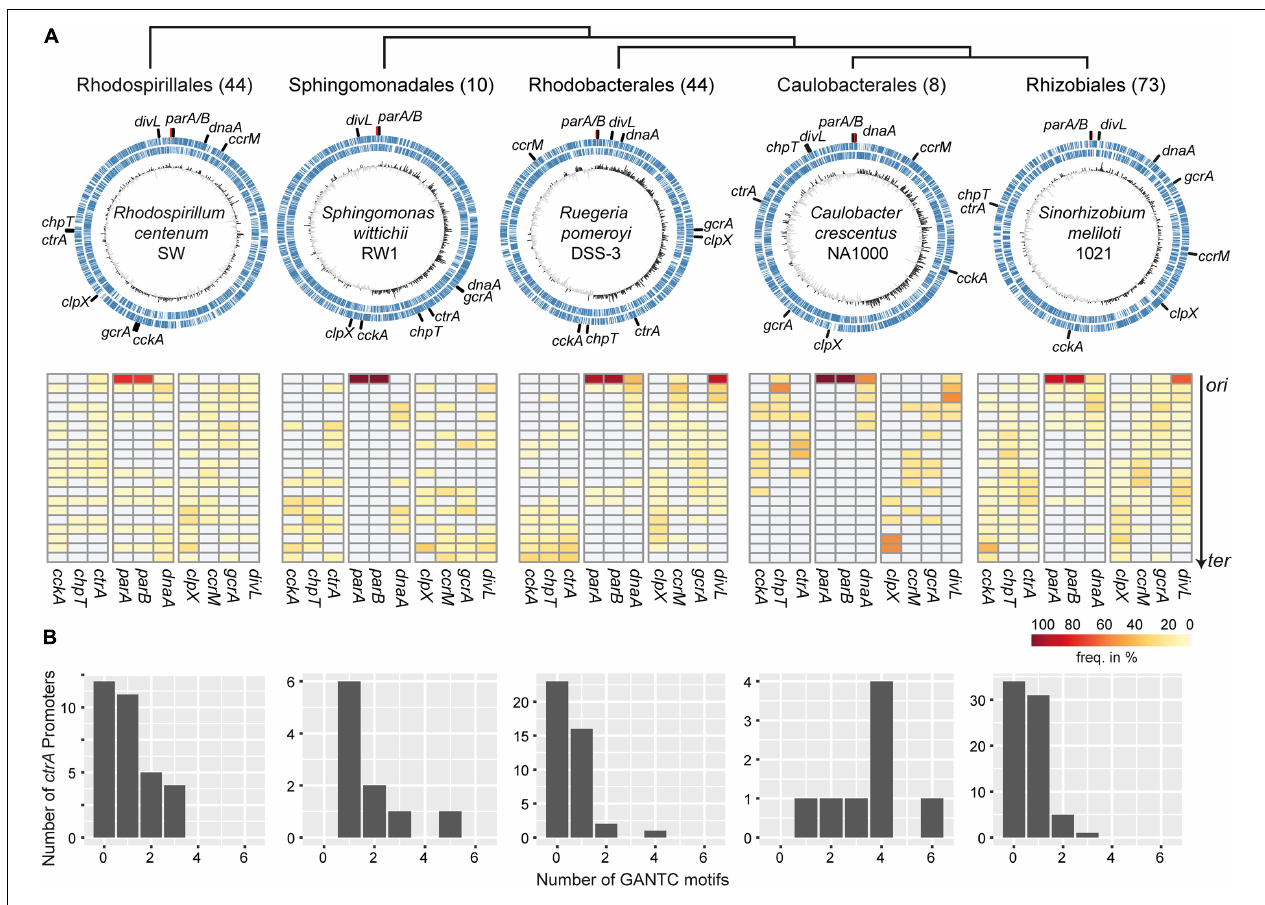
FIGURE 2 | Chromosomal localization of CtrA phosphorelay component genes and methylation of the ctrA promoter region in alphaproteobacteria. (A) Alphaproteobacterial orders are arranged according to Muñoz-Gómez et al. (2019). The numbers of genomes per order are in brackets. Upper panel: representative chromosomes for each order with positions of regulators marked. Lower panel: percentage of regulator genes within 20 segments of the chromosomes of the particular order oriented along the ori - ter axis. (B) Distribution of the number of CcrM methylation motifs in the ctrA promoter regions for each